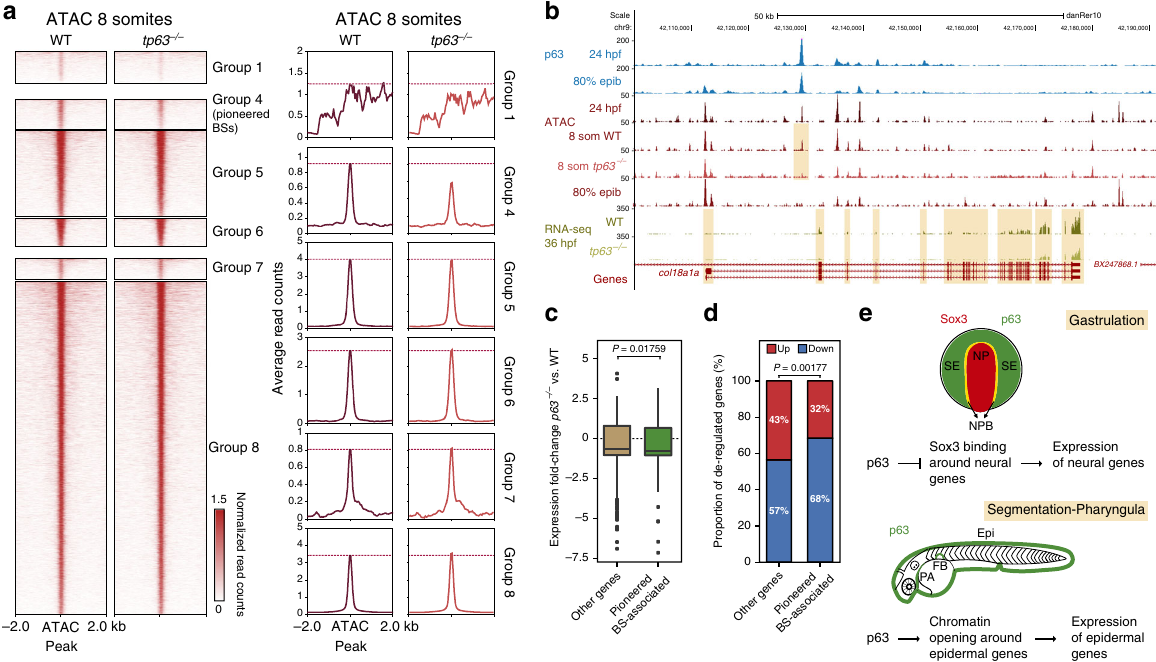
Fig. 6 p63 acts as a pioneer TF to promote epidermal gene expression. a Heatmaps (left) and average pro fi les (right) of ATAC-seq signal from WT and tp63 − / − embryos in 8 somites stage ( n = 2 biological replicates per condition) for the groups resulting from the alluvial plot transitions from Fig. 5a. A dotted red line represents the WT pro fi le peak in each stage. Groups 2 and 3 were omitted from the analyses due to their small number of peaks. b Genome tracks of p63 ChIP-seq, ATAC-seq and RNA-seq in the indicated developmental stages showing signal intensities in a region of chromosome 9. A down-regulated ATAC-seq peak in tp63 − / − mutant and the associated down-regulated gene ( col18a1a ) are highlighted in light orange. The Genes track represents ENSEMBL annotated genes. c Box plots showing the expression fold-change in tp63 − / − embryos of the transcripts associated to group 4 ATAC- seq peaks ( n = 227) compared to the remaining de-regulated transcripts in that mutant ( n = 2,117). Center line, median; box limits, upper and lower quartiles; whiskers, 1.5× interquartile range; points, outliers. Statistical signi fi cance was assessed using the Wilcoxon ’ s rank sum test. Source data are provided as a Source Data fi le. d Proportion of up- and down-regulated transcripts in tp63 − / − embryos associated to ATAC-seq peaks from group 4 compared to the remaining de-regulated transcripts in that mutant. Statistical signi fi cance was assessed using the Fisher ’ s exact test. e Model proposed to illustrate the dual role of p63 during ectoderm speci fi cation. During gastrulation (top), p63 prevents Sox3 binding to enhancers associated to neural genes probably in the neural plate border, where they are co-expressed, resulting in the inhibition of neural expression. During segmentation and pharyngula (bottom), non-accessible chromatin at enhancers associated to epidermal genes and bound by p63 during gastrulation becomes open, triggering an epidermal transcriptomic program that results in the differentiation of epidermis and related structures. NP neural plate, SE surface ectoderm, NPB neural plate border, Epi epidermis, FB fi n bud, PA pharyngeal arches. See also Supplementary Fig. 5